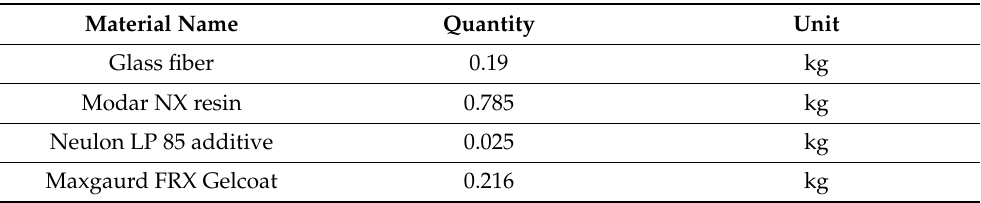
Table A1. The quantities used for modeling 1 kg of fiberglass in Ecoinvent.